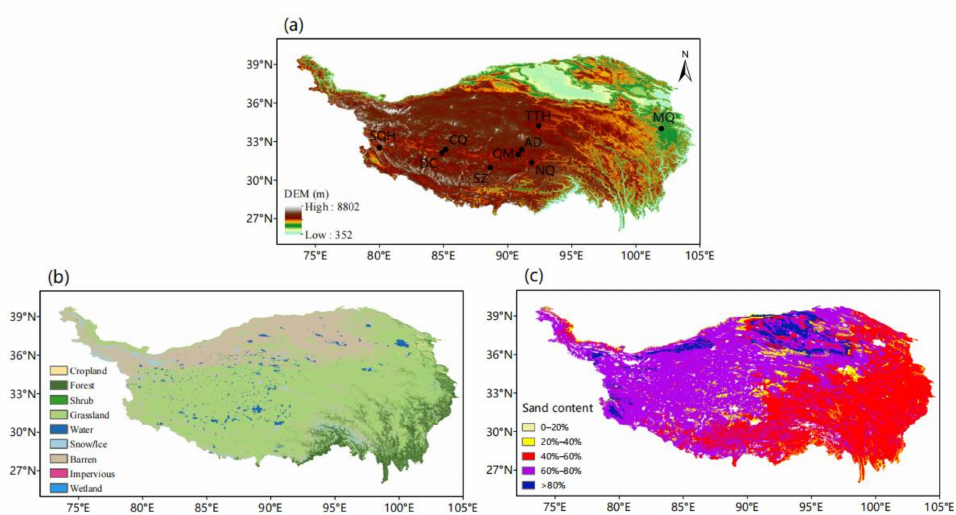
Figure 1. Spatial distribution of ( a ) topographic height, ( b ) land cover and ( c ) soil sand percentage. Black dots present the nine observation stations on the Tibetan Plateau (TP): Shiquanhe (SQH), Dongcuo (DC), Cuoqin (CQ), Shenzha (SZ), Qiangma (QM), Anduo (AD), Naqu (NQ), Tuotuohe (TTH), and Maqu (MQ). The 30 m resolution land cover in ( b ) is obtained from the Earth System Science Data [36]. The soil sand content data in ( c ) is from Resources and Environmental Sciences, Chinese Academy of Sciences (RESDC) (http://www.resdc.cn (accessed on 1 January